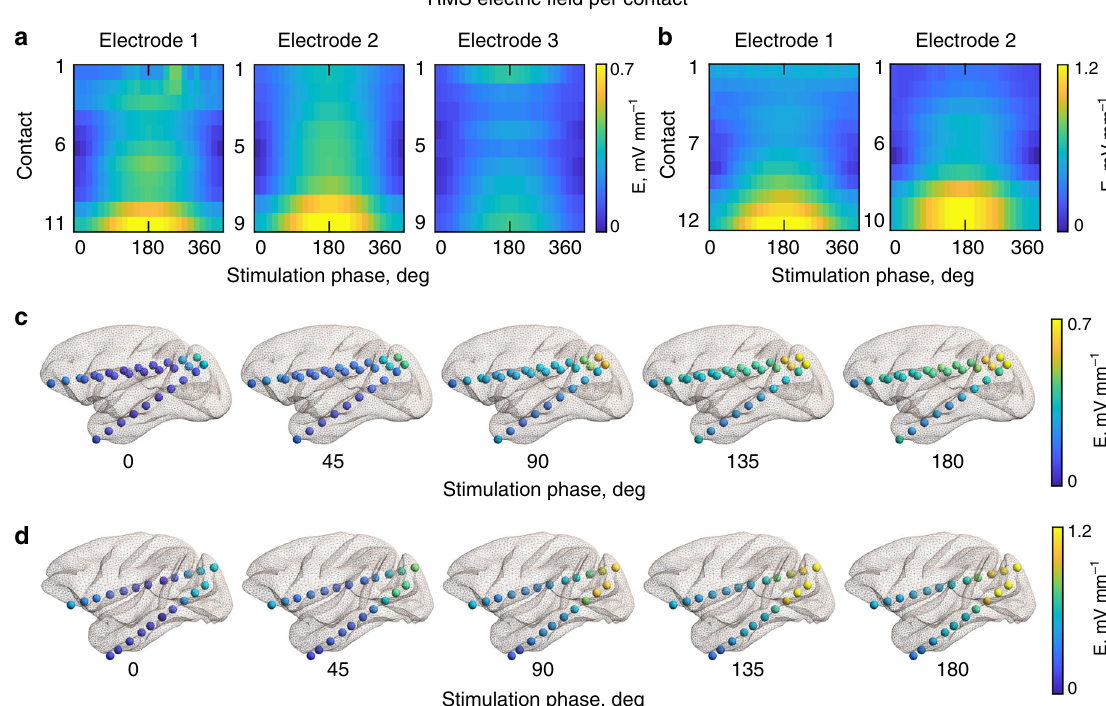
Fig. 3 TES electric fi eld distribution for different stimulation conditions. a Heatmaps of the root mean square magnitude (RMS) of the electric fi eld for each recording electrode for subject 1 (left) and subject 2 (right, b ). The x -axis indicates the applied phase difference between the anterior and posterior stimulation electrodes from 0° to 360° in 15° steps, and the y -axis corresponds to the recording contacts (from the fi rst — most anterior contact, to the last — most posterior contact). c Electric fi eld distributions in the brain for select stimulation conditions for subject 1 and subject 2 ( d ). See also electric fi elds for three main stimulation conditions (0°, 90°, and 180°; see also Supplementary Movies 2 and 3). Stimulation in the 180° condition leads to a unidirectional electric fi eld for all time- points. The electric fi eld direction is periodically switching from an anterior- > posterior to a posterior- > anterior orientation.